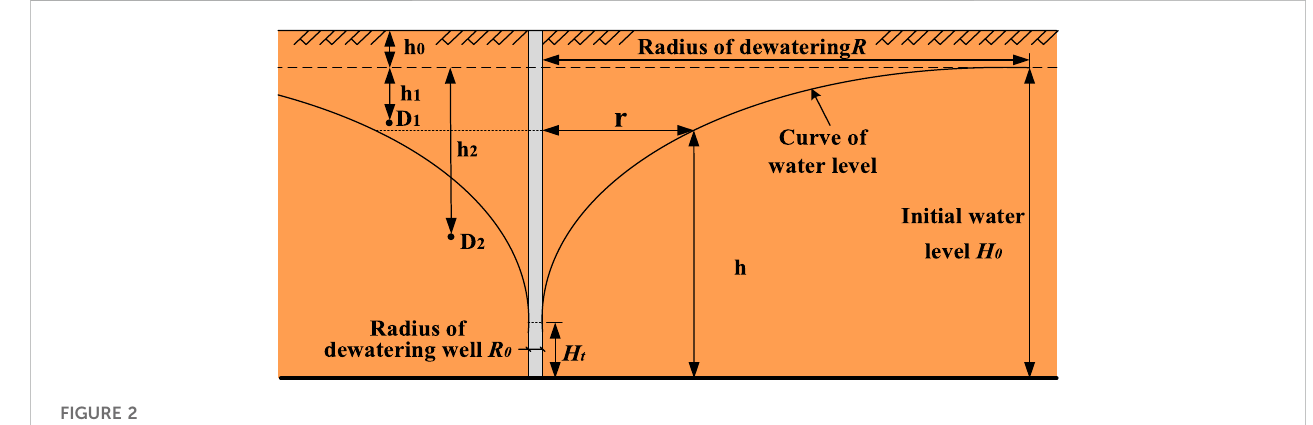
FIGURE 2 Curve of water level after